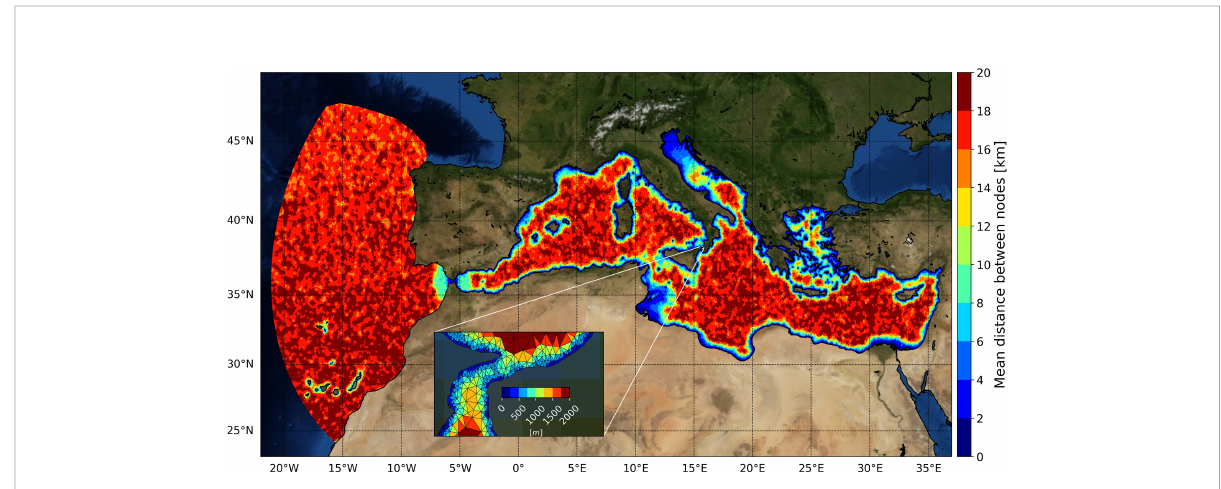
FIGURE 1 Mean distance (km) between nodes of the same element over the whole